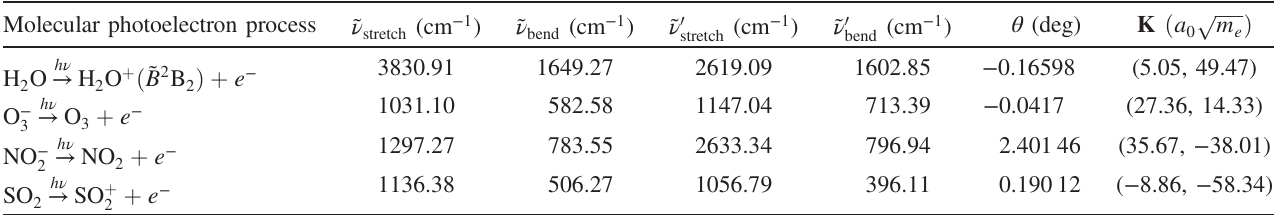
TABLE II. Theoretically optimized molecular parameters. Vibrational frequencies for the symmetric-stretching and bending modes of ˜ ν 0 ) states are provided in wave numbers (cm − 1 ), which is related to angular frequency ω via each molecule in pre- ( ˜ ν ) and post-transition ( ˜ ν ¼ ω = 2 π c , where c is the speed of light. The rotation angle corresponding to the Duschinsky rotation matrix is defined in Eq. (A2). The is the electron mass) and shift vector K ¼ ð k 1 ; k 2 Þ is provided in mass weighted normal coordinates (where a 0 is the Bohr radius and m e reflects the relative displacement of equilibrium geometries between the two molecular configurations. Molecular photoelectron